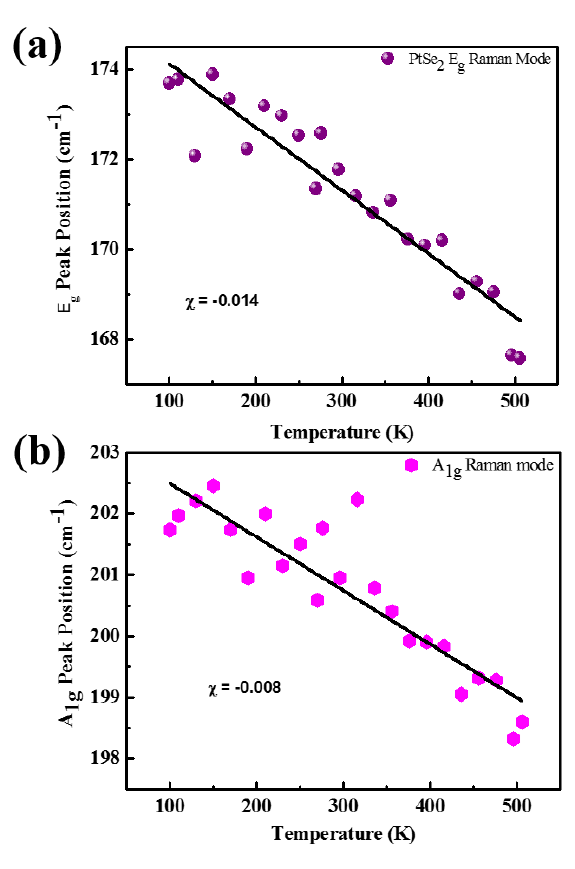
Figure 6: Temperature-dependent Raman spectra analysis for PtSe 2 nanosheets for the (a) E g mode and the (b) A 1g mode as a function of temperature.